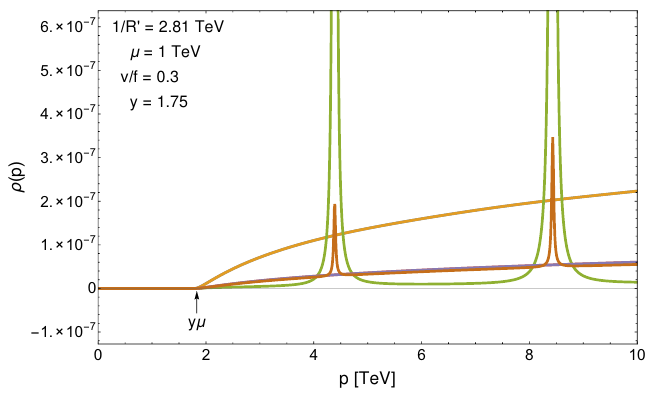
Figure 11 . Spectral densities for additional exotic top